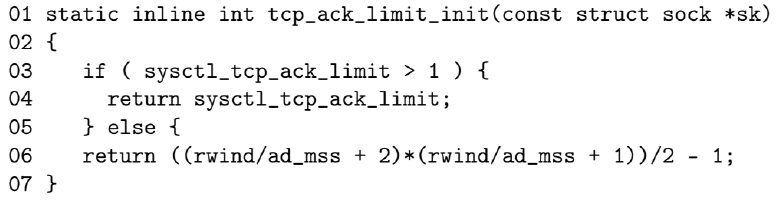
Figure 3. Changes in Linux kernel tcp.h source code for a new tcp_ack_limit_init() .